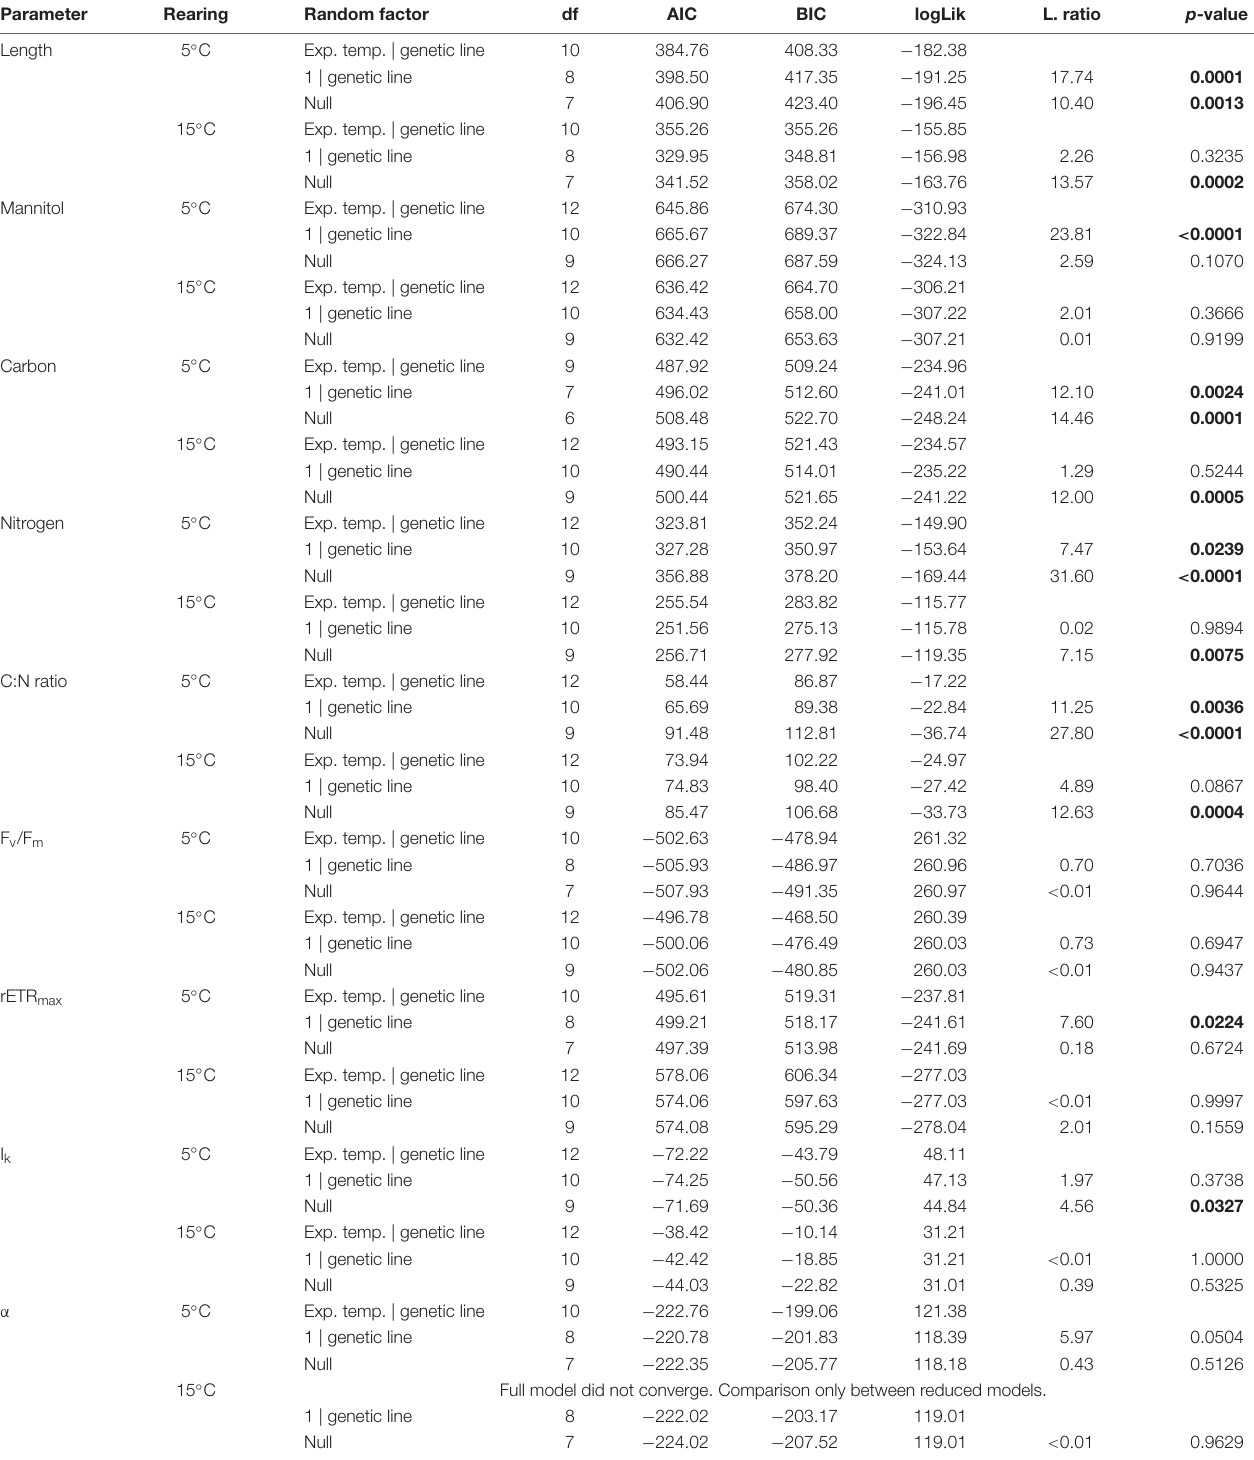
TABLE 3 | Results of likelihood ratio tests to determine significance of the random effects “experimental temperature | genetic line” (GxE; random slope) and “1 | genetic line” (G; random intercept) on tested parameters in juvenile Laminaria digitata sporophytes in experiment 2.